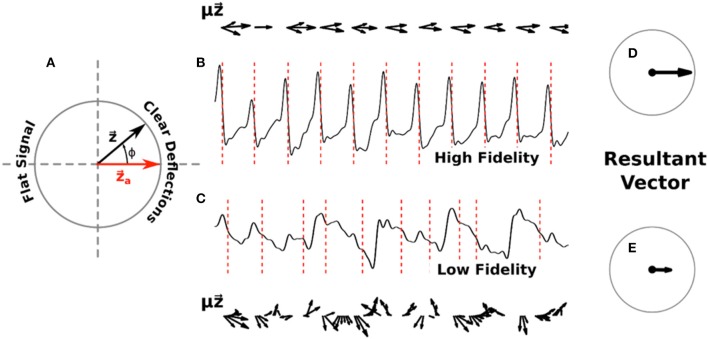
Diagram of signal fidelity computation. (A) A visual representation of phase in the complex plane. The red vector z⇀a represents activation, with the complex phase vector z⇀ rotating counter-clockwise around the unit circle as determined by the computed phase of a given signal. (B) A sample filtered electrogram with high signal fidelity, exhibiting clear deflections which are well-marked by the computed activations (red dotted lines). Phase vectors z⇀(t), scaled by the deflection amplitude μ(t), are shown above this trace in 10 ms increments. (C) A sample filtered electrogram with low signal fidelity, exhibiting ambiguous deflections. Phase vectors z⇀(t), scaled by the deflection amplitude μ(t), are shown below this trace in 10 ms increments. For clarity, vectors with magnitude below a minimum threshold are not shown. Panels (D) and (E) show the normalized vectors resulting from the sum of scaled phase vectors for each respective trace across 20 s of data. Signal fidelity is computed as the dot product of this resultant vector and z⇀a.